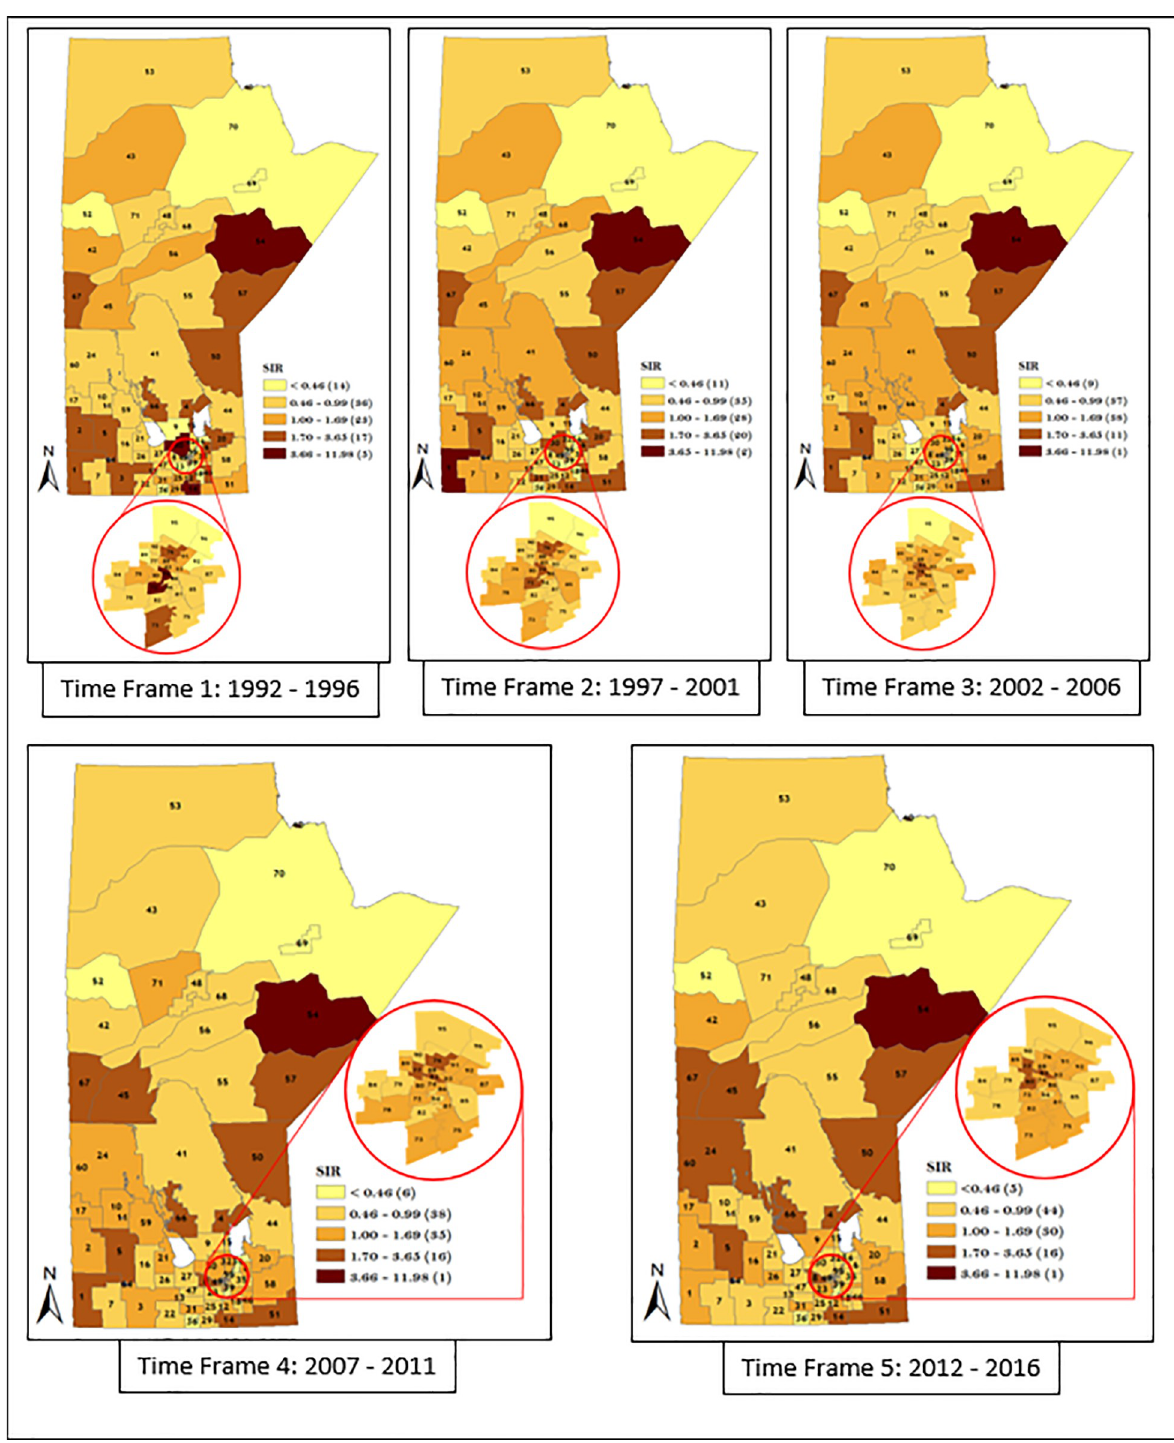
Fig 14. Maps of district-specific risk of NCGC for 96 RHADs in Manitoba for five time periods using spatio-temporal Poisson regression model. Numbers in the map are the district labels from 1 to 96. Number of districts in each risk category is shown in parenthesis in the legends.